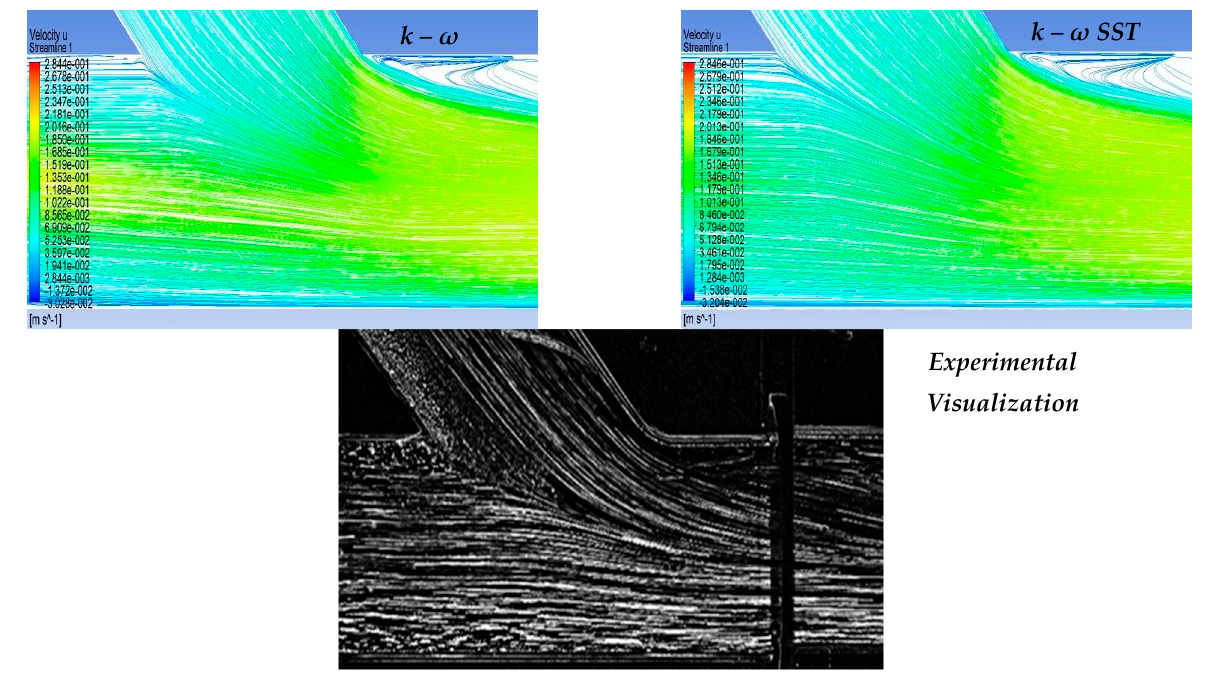
Figure 8. Qualitative comparison of flow models for 47–53% stenosis/anastomosis flow rate ratio.